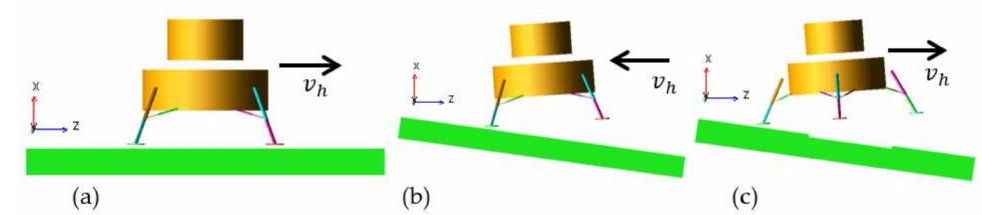
Figure 9. Diagrams of three severe landing case. ( a ) High-overloading case; ( b ) Easily overturning case; ( c ) Long-stroke case.